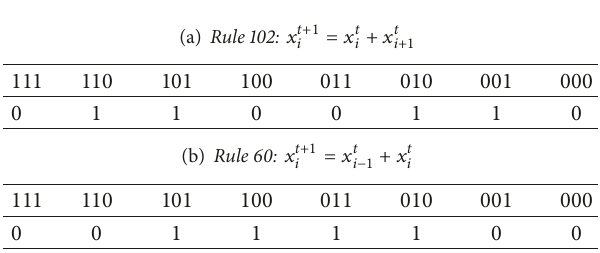
= 1 , for 𝑖 = 0, 1, . . . , 15 𝑖